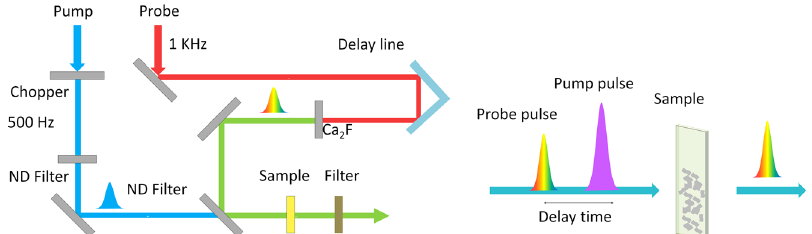
Figure 2: Experimental diagram of an all- optical